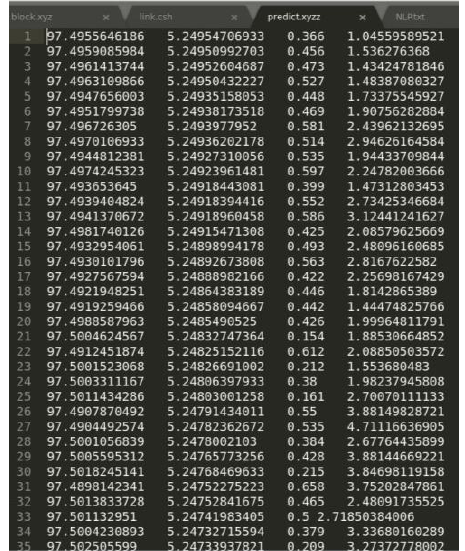
Figure 6. The differences between height value from masspoints and DSM (column: longitude, latitude, height, height difference).